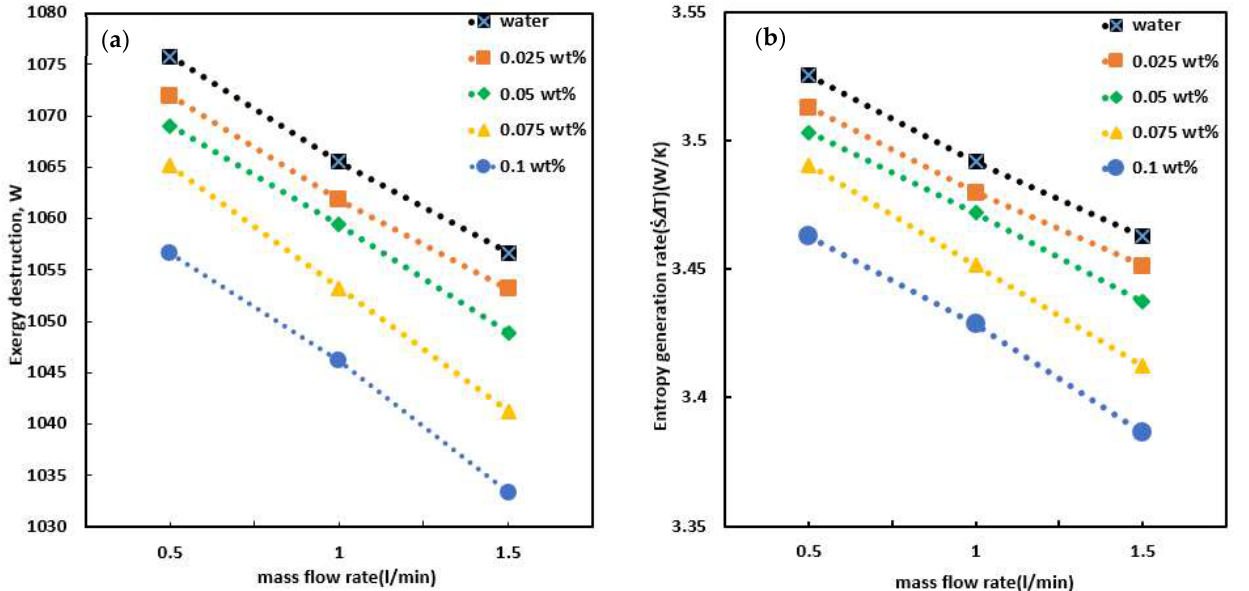
Figure 5. ( a ) Variation of exergy destruction with respect to mass flow and concentration and ( b ) effect of volumetric flow rate on entropy generation.